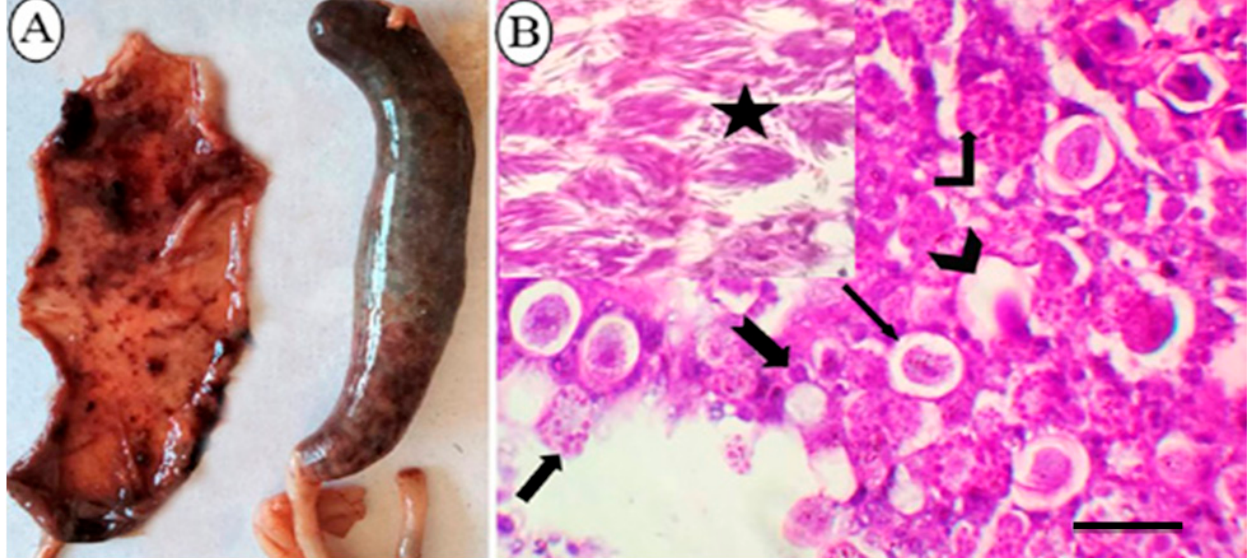
Figure 1. The pathological findings in ceca of E. tenella naturally infected broiler chickens. ( A ): Gross appearance of ceca showing severe congestion and dilatation and filled with bloody contents with friable cecal wall and loss of its lining mucosa. ( B ): Histopathological cecal section illustrating the distinct developmental stages of E. tenella ; mature oocyst with a central nucleus and oocyst wall (Chevron arrow); immature oocyst with a central nucleus and oocyst wall (thin arrow); macrogametes with bordering eosinophilic bodies and a central nucleus (Bent-up arrow); microgametes (Thick arrow); developing schizont (notched arrow), mature second stage schizonts (star) arranged in groups and having several crescent-shaped merozoites (H&E, bar = 50 μ m).